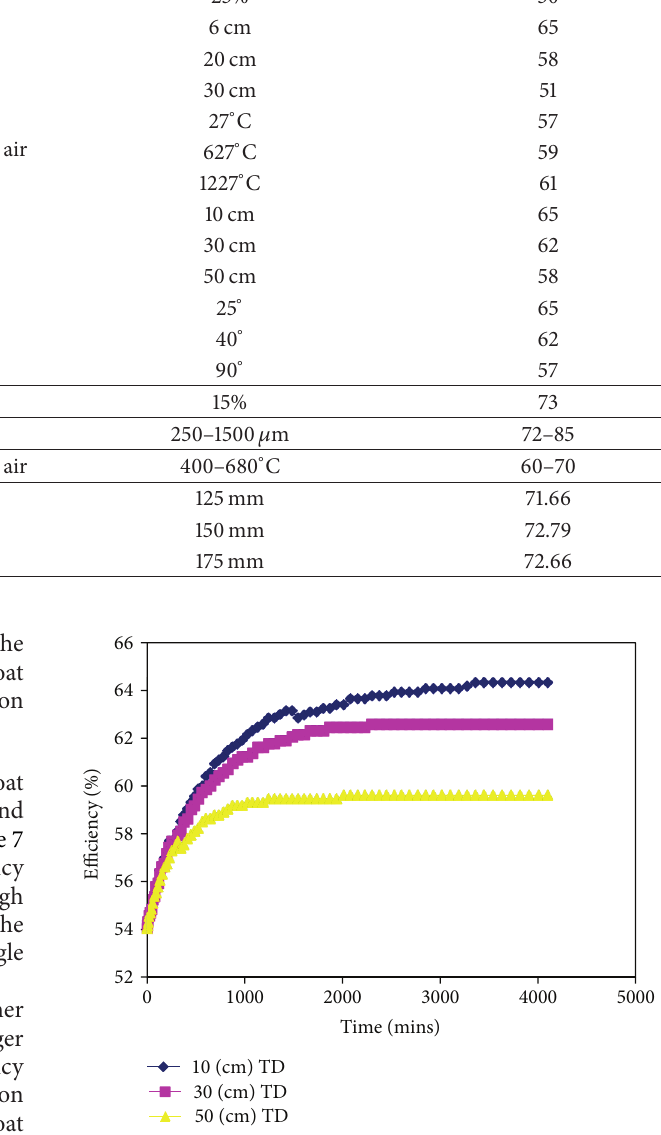
Figure 6: The impact of throat diameter on conversion